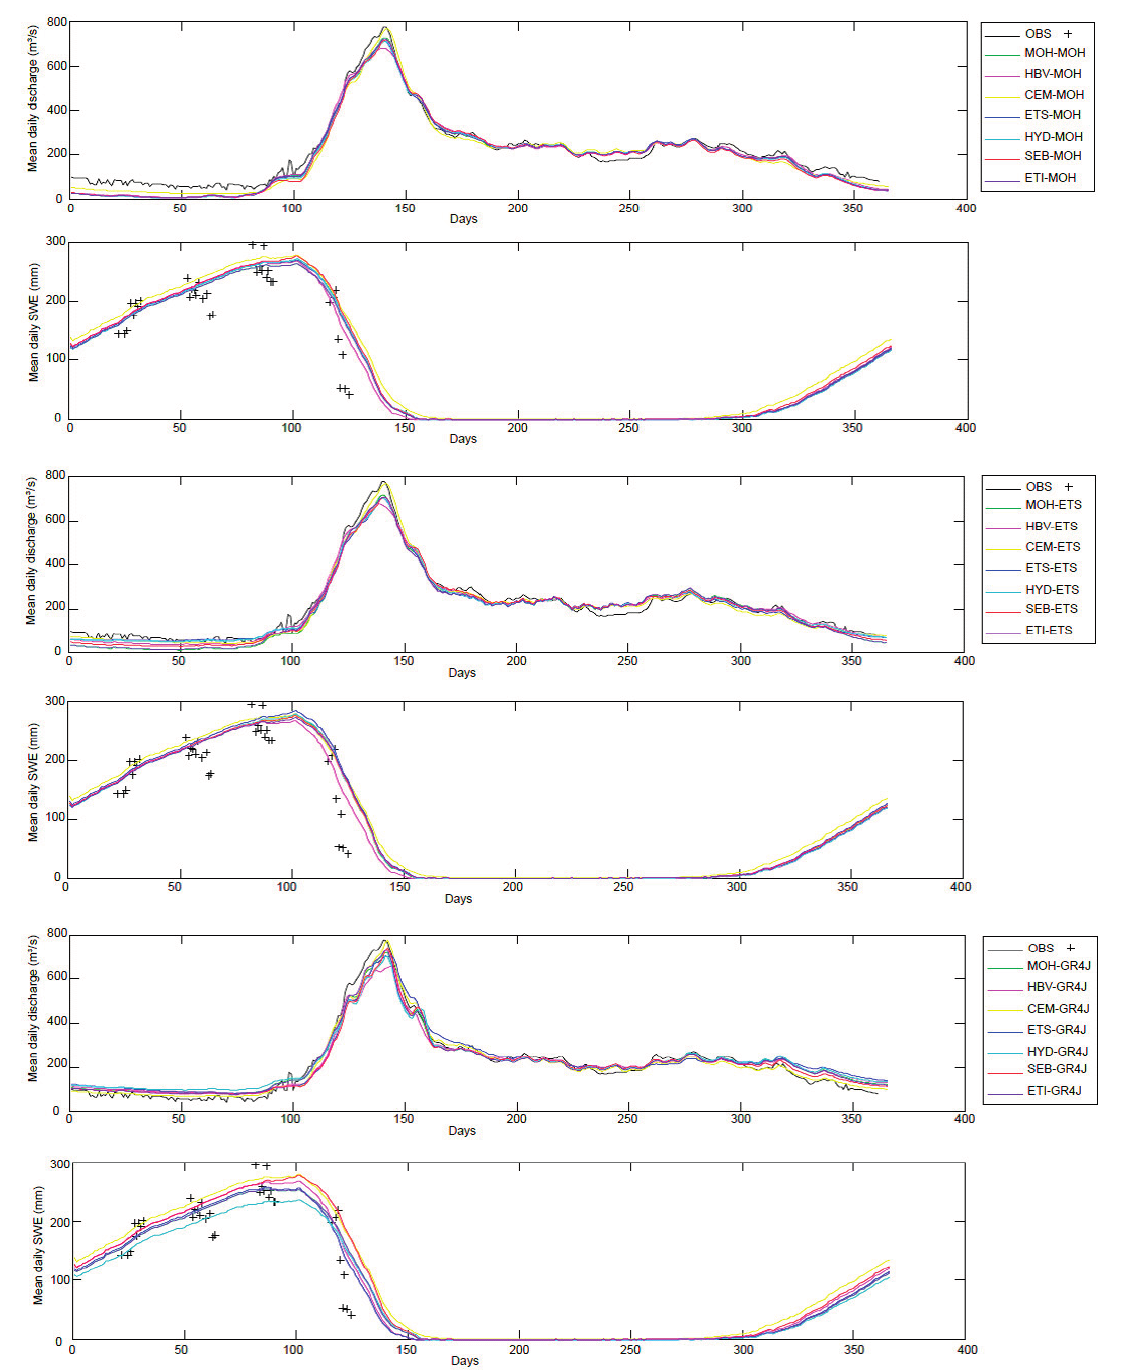
Figure 5. Mean annual hydrographs of observed (OBS), simulated discharges and SWEs using the 21 SM-HM combinations over the calibration period (even years over